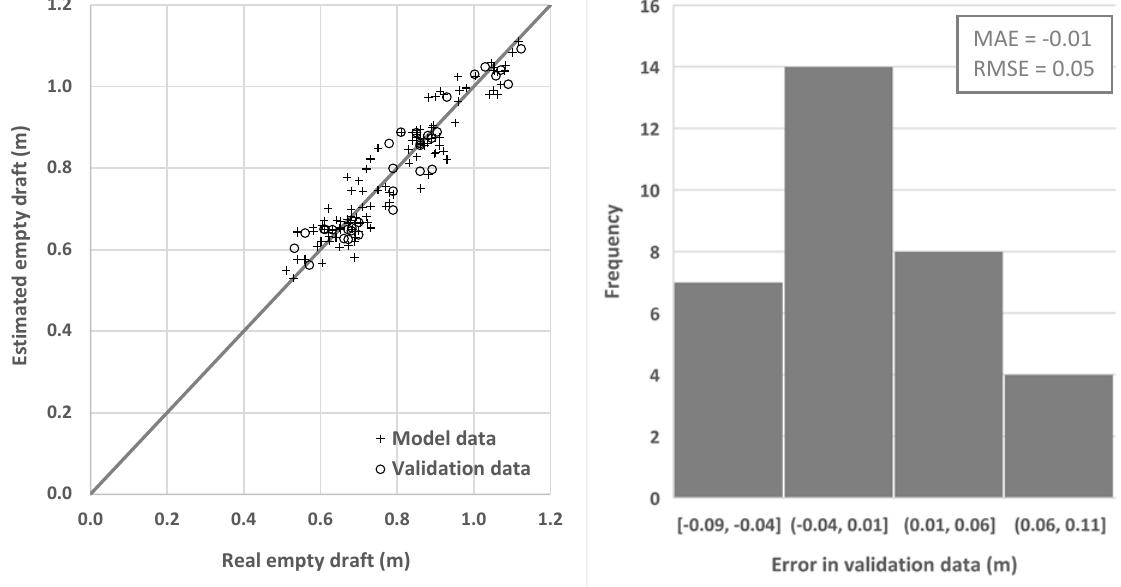
Figure 9. Empty draft model validation and histogram of error